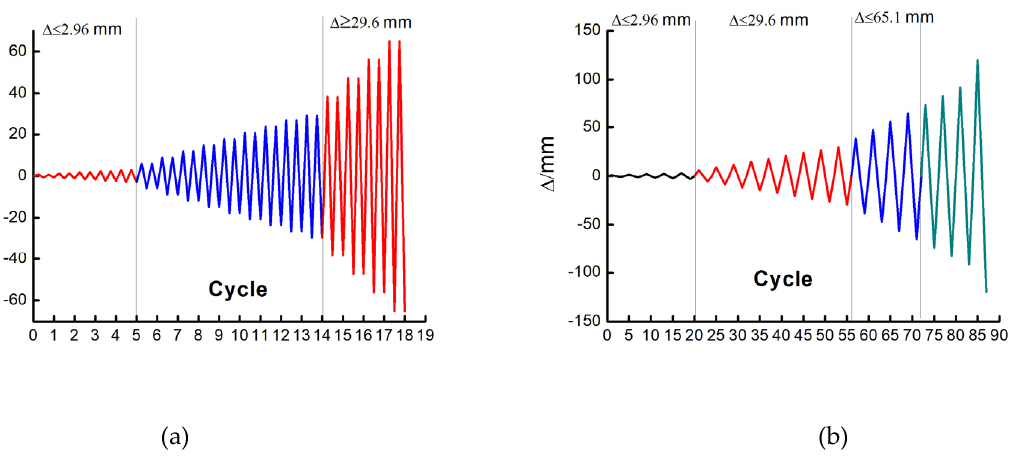
Figure 5. Loading protocols. ( a ) Loading protocol for the EDCW; ( b ) loading protocol for the steel frames.